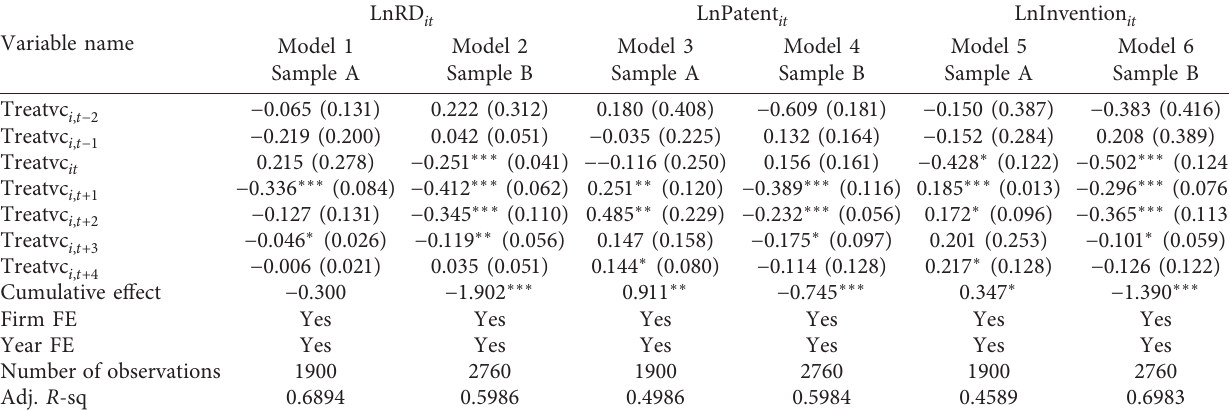
Table 3: PSM sample regression results: impact of VC on the innovation level of technology-dependent